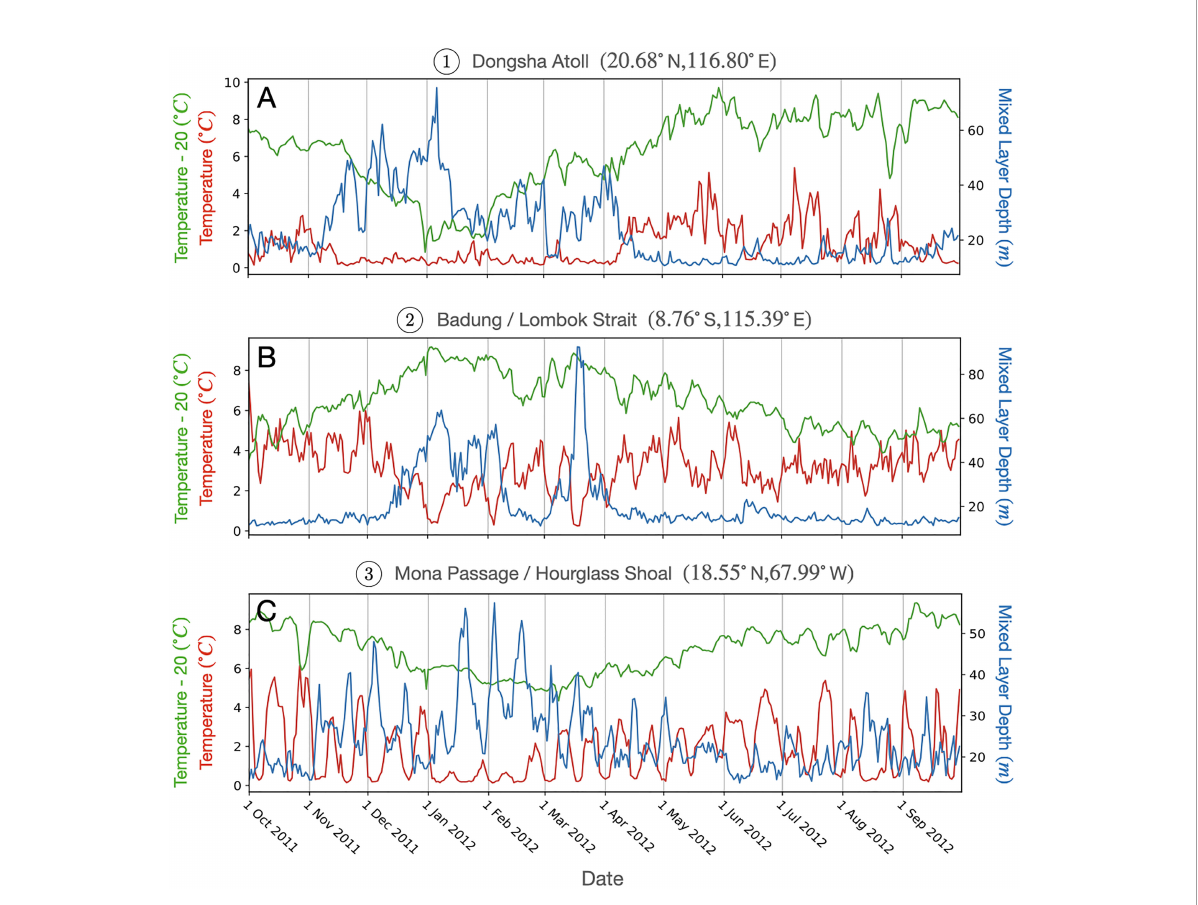
FIGURE 5 Time series of sea surface temperature (SST, green), daily temperature variation at 10 m (red), and mixed layer depth (MLD, blue) for the locations indicated in Figure